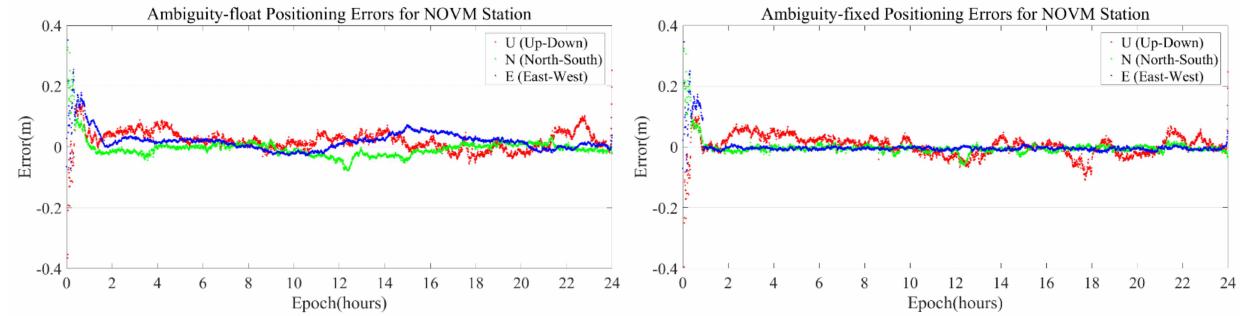
Figure 3. The time series of NOVM station position errors between the ambiguity-float ( left subgraph ) or ambiguity-fixed ( right subgraph ) solution and IGS-released data.